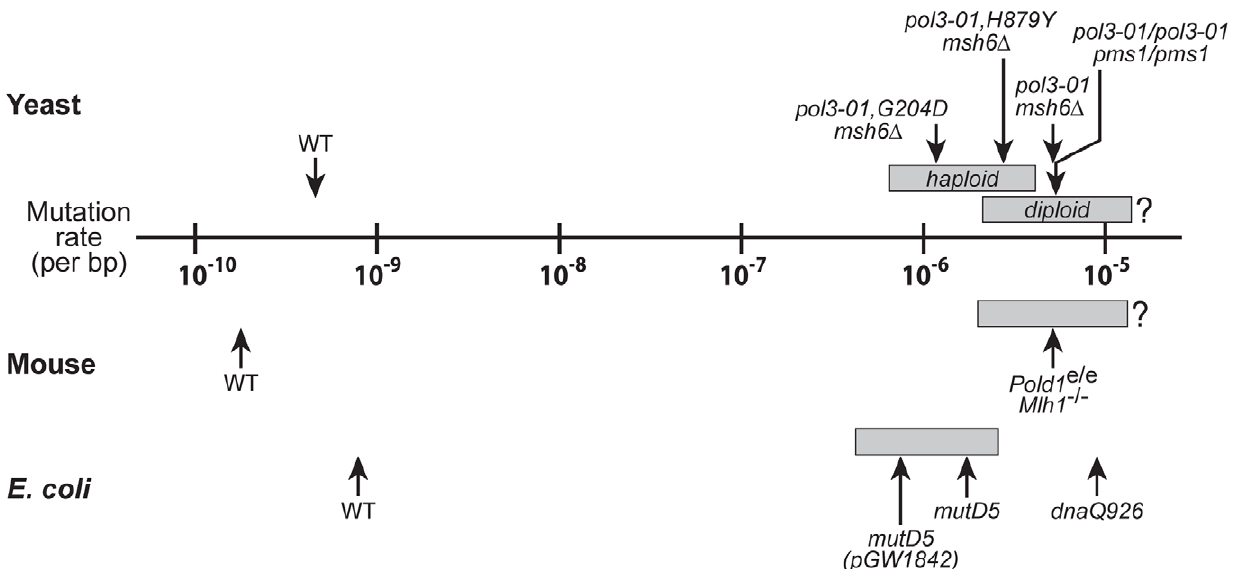
Figure 6. Mutational robustness of yeast, E.coli , and mice. Comparison of spontaneous per-base-pair mutation rates of wild-type (WT) and strong mutator strains of yeast (haploid and diploid), E. coli and mouse cells. Gray boxes indicate the mutation rate intervals that coincide with the transition from wild-type growth (leftmost boundary) to failed growth (rightmost boundary). The data for haploid yeast mutators are from Figure 5B, with the left boundary corresponding to the mutation rate of pol3-01,E642K msh6 D cells (6.5 6 10 2 7 ) and the right boundary corresponding to the lethal threshold (4.1 6 10 2 6 ). The mutation rates of pol3-01,G204D msh6 D , pol3-01,H879Y msh6 D , and pol3-01 msh6 D haploid yeast are shown as examples of progressively stronger mutators with slow ( ++ ), very slow ( + ) and no-growth (–) phenotypes, respectively. The data for pol3-01/pol3-01 pms1/pms1 diploid yeast are from Morrison et al. [40]; pol3-01/pol3-01 pms1/pms1 cells divide very slowly with a growth phenotype presumably in the range of + to ++ . The mouse Pold1 e/e Mlh1 D / D mutation rate is extrapolated from ouabain-resistance rates of cultured Pold1 + /e Mlh1 D / D fibroblasts as described in Materials and Methods; a growth phenotype between + and ++ is assumed [25]. E. coli mutation rates and growth phenotypes are from Fijalkowska et al. [62]; mutD5(pGW1842) , mutD5 and dnaQ926 exhibit slow ( ++ ), very slow ( + ) and no-growth (–) phenotypes, respectively. The positions of the gray boxes for diploid yeast, mouse and E. coli are estimates based on the mutation rate and growth capacity relationships observed in haploid yeast (Figure 5B). The error thresholds (rightmost boundaries) for diploid yeast and mouse cells are not known. The yeast wild-type rate is the average of multiple independent determinations (data herein and [40,108,114,124]). Wild-type mouse and E. coli mutation rates are from Drake et al.